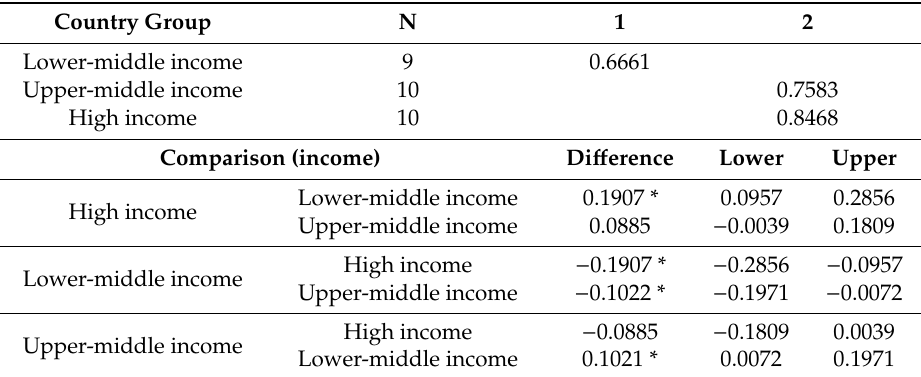
Table 9. Di ff erences in ranking by